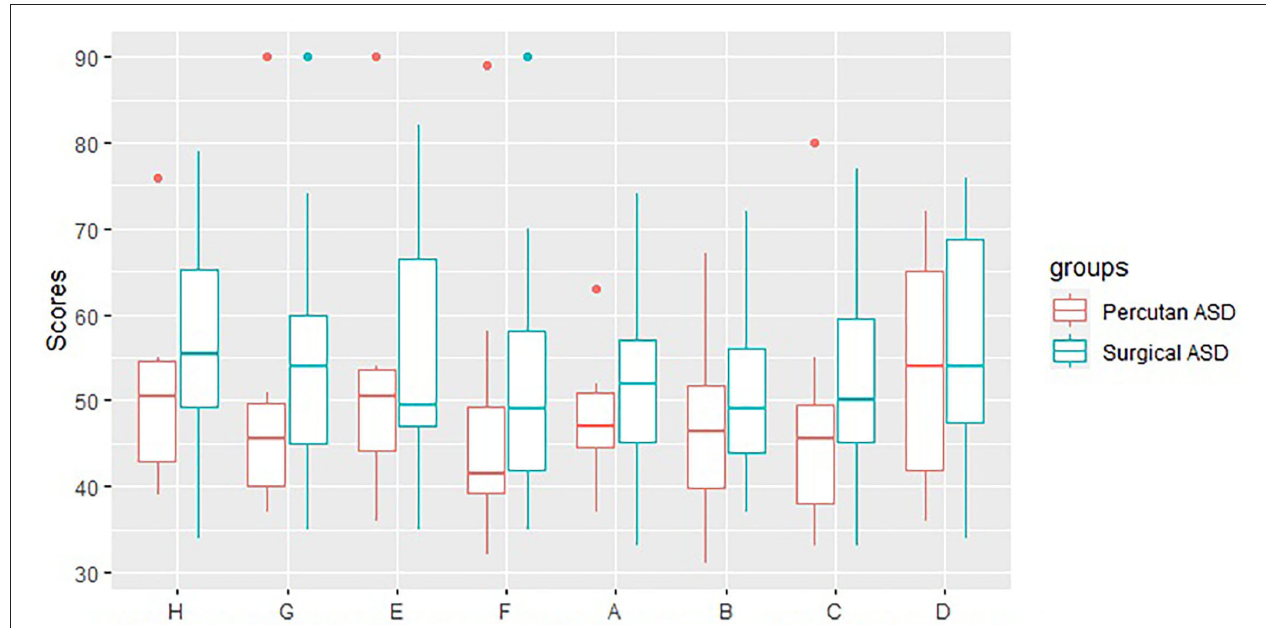
FIGURE 2 | CAARS scores for Perctuaneus ASD and Surgical ASD. H: ADHD-Index, G: ADHD-Combined, E: ADHD-Inattention, F: ADHD-Hyperactivity, A: Innatention/Memory problems, B: Hyperactivity/Restlessness, C: Impulsivity/Emotional lability, D: Self-esteem problems.